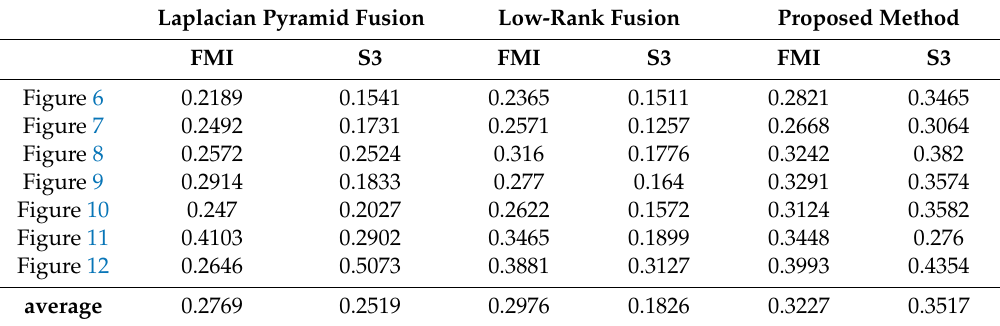
Table 1. Comparison of image quality metrics.